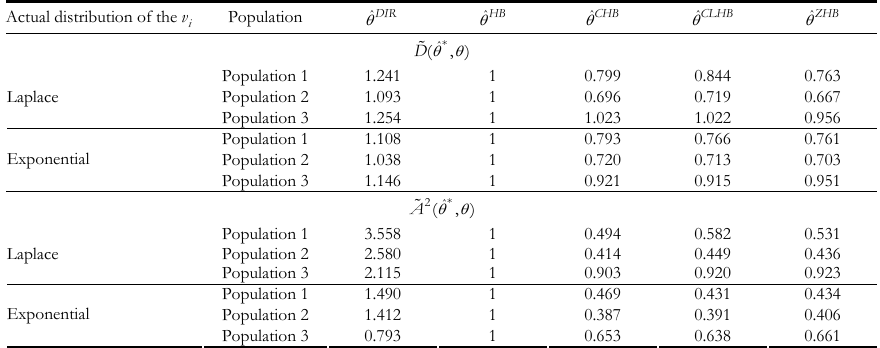
Comparison of adjusted estimators under failures of the distributional assumption on random